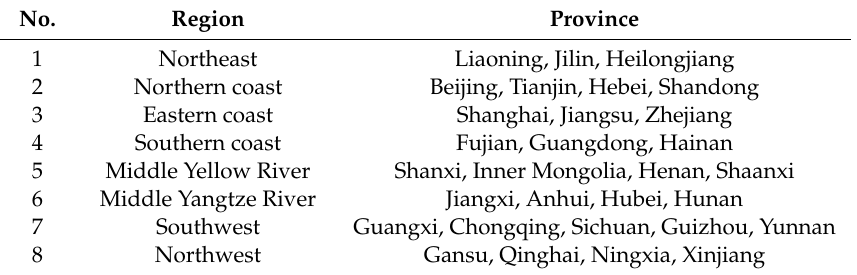
Table A1. Classification of China’s 30 provinces into eight